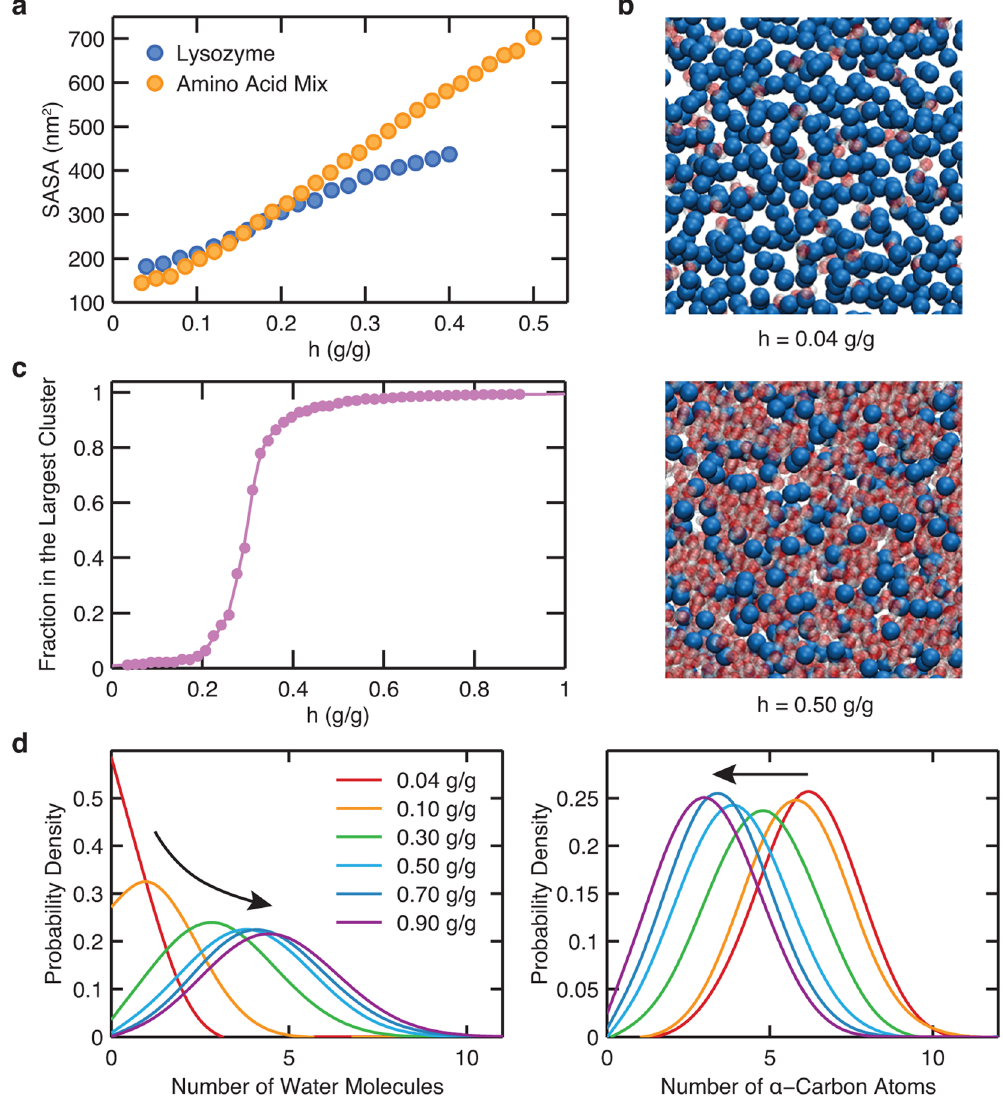
Figure 4. ( a ) Solvent-accessible surface area (SASA) as a function of hydration level during the adsorption process. The error bars are either explicitly shown or smaller than the size of the symbols. ( b ) Visualization of the α -carbons (blue) and the water molecules (red) of the amino acid mixture at low ( h = 0.04 g/g, top) and high ( h = 0.50 g/g, bottom) hydration levels. ( c ) Fraction of water molecules that belong to the largest cluster as a function of hydration level. Best-fit line is drawn as a guide to the eye. ( d ) Probability distribution of the number of water molecules (left) and α -carbon atoms (right) within the first coordination shell from the α -carbon atoms of the amino acid mixture at varying hydration levels. Although these distributions are discrete in nature, we show them as continuous for visual clarity in comparing among different hydration levels. Arrows indicate the direction of increase in hydration